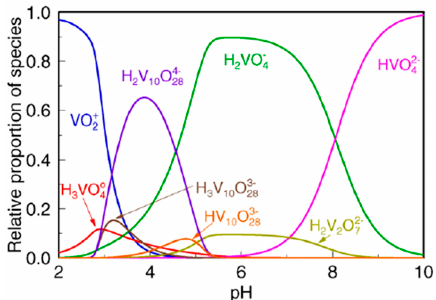
Figure 4. Distribution of vanadium(V) species in function of pH (initial vanadium concentration = 0.5 mM, T = 25 °C, 1 atm, ionic strength 0.15 M NaCl) taken from [74].